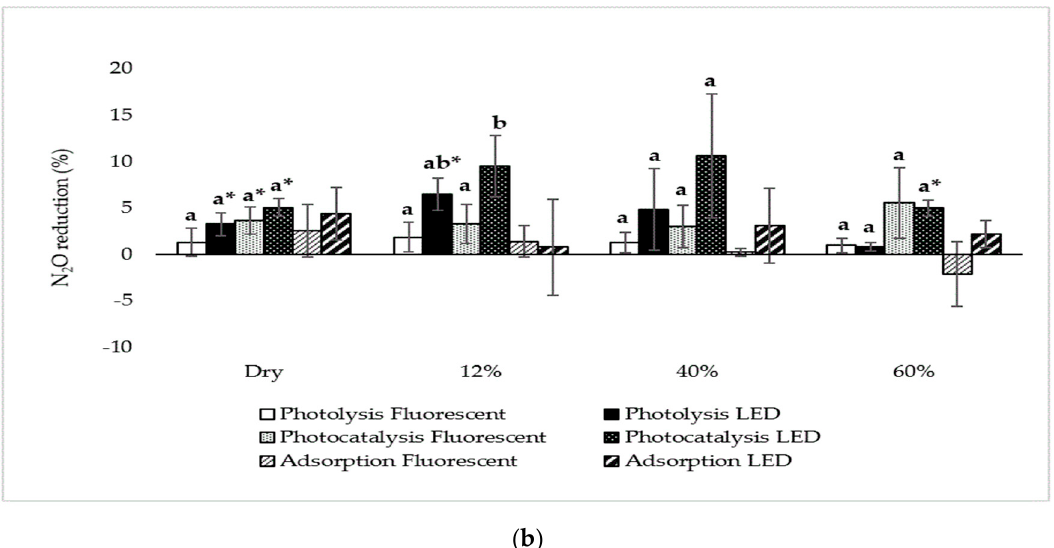
Figure 12. Comparison of N 2 O mitigation under different treatment types and light type intensity. ( a ) % reduction at treatment time of 40 s; ( b ) % reduction at treatment time of 200 s; Superscript (*) signifies a statistical difference compared to the control ( p < 0.05), and the different characters (a, b) signify statistical difference when comparing different light intensities (fluorescent vs. LED) at the same relative humidity ( p < 0.05). Error bars signify ± standard deviation.